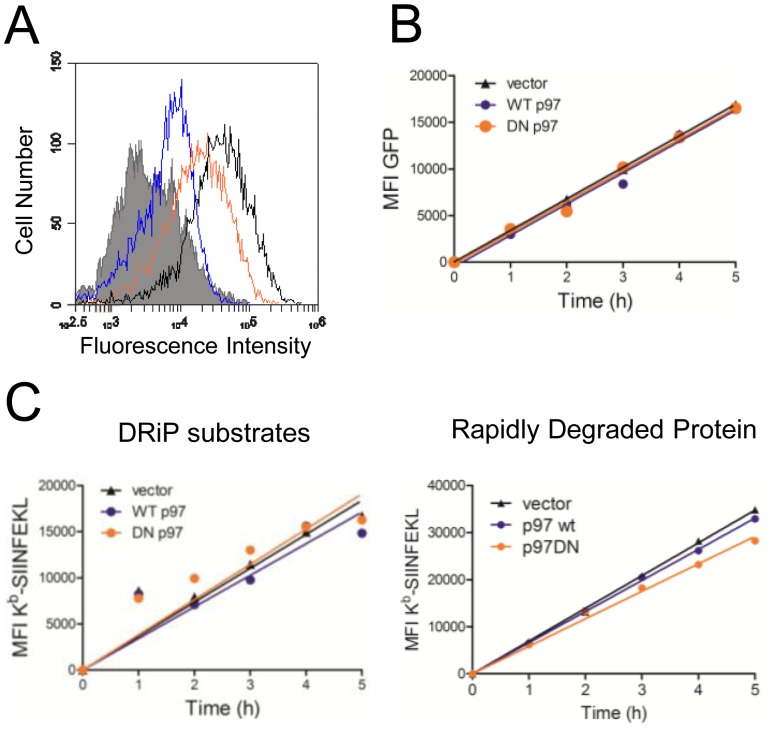
Genetic ablation of p97 does not diminish DRiP antigen presentation.
A. EL4/SCRAP cells were placed in ice-cold citric acid buffer (pH 3) for 2 minutes, washed, re-suspended in tissue culture media, and cultured for 5 hours in the presence of shield-1 before staining with the monoclonal antibody 25D-1.16 to detect Kb-SIINFEKL complexes at the cell surface. Kb-SIINFEKL complexes recovered from near background levels (blue trace) to approximately 50% (orange trace) the level of cells that had not been washed in acid (black trace). EL4 cells that do not express Kb-SIINFEKL are shown as a negative control (shaded histogram) and are considered background 25D- 1.16 staining. B and C. EL4/SCRAP cells were transfected with either an empty vector, wild type (WT) or DN p97 constructs and 24 hours later, washed in mild citric acid to elute existing peptides from MHC class I molecules. Cells were then treated with 5 µM shield-1 and cultured for 5 hours. At indicated times cells were collected and analyzed by FACS. Cells expressing Thy1.1 were subsequently analyzed for GFP expression (B) and the mean fluorescence intensity (MFI) plotted. Kb-SIINFEKL expression (C) was analyzed for both DRiP substrates (left) and the rapidly degraded form of SCRAP (right) and the MFI plotted as a function of time.